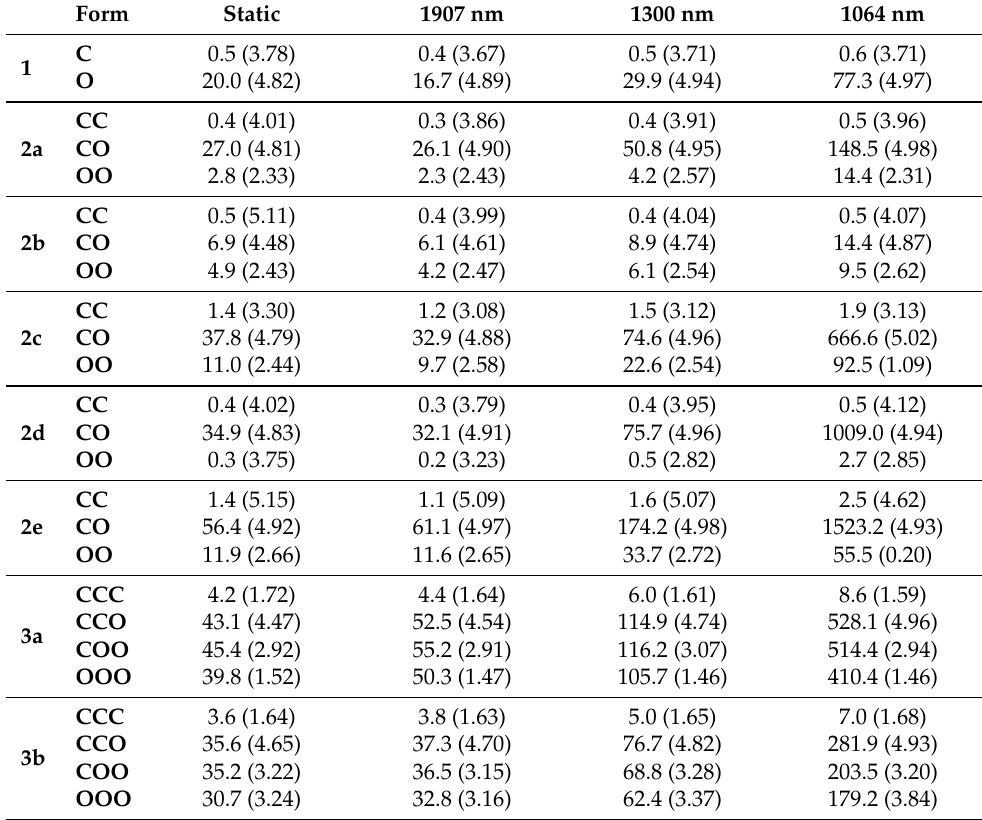
Table 2. Static and dynamic (1907, 1300, and 1064nm) first hyperpolarizabilities ( β HRS in 10 3 a.u., the DR in parentheses) of compounds 1 – 3 in their different forms, as evaluated at the TDDFT/M06- 2X/6-311+G(d)/IEF-PCM (acetonitrile) level of approximation. These are averaged values using the MB populations at 298.15K as calculated at the ω B97X-D/6-311G(d)/IEF-PCM (acetonitrile) level of